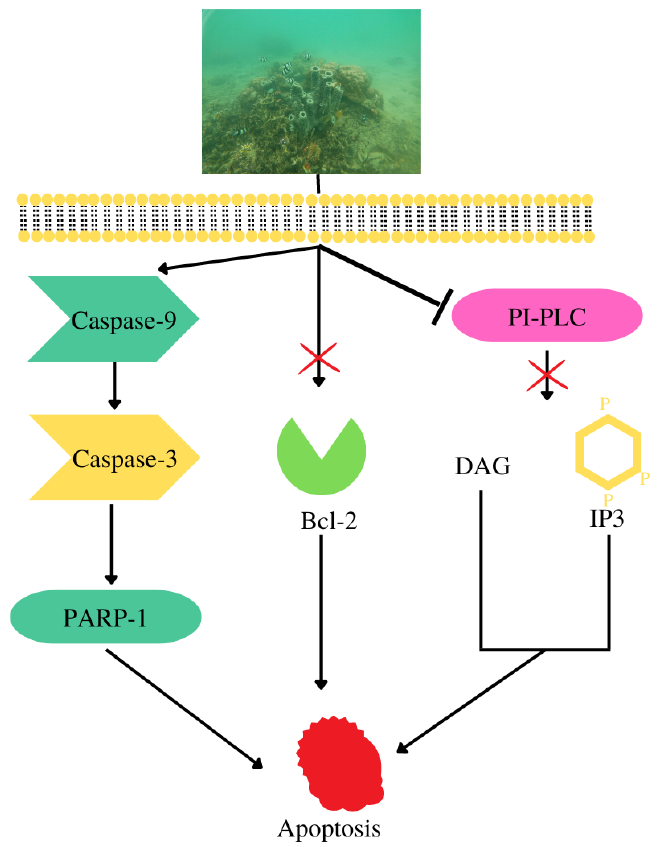
Figure 8. Cell death mechanisms of Callyspongia aerizusa compounds.